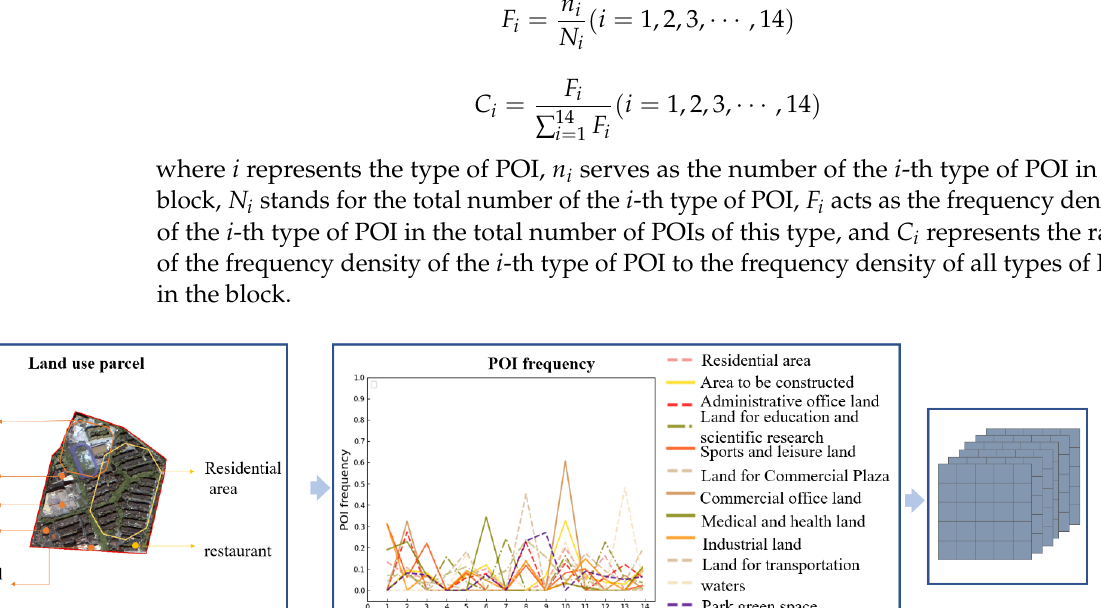
Figure 3. Building footprint of the study area. ( a ) building height distribution. ( b ) building length distribution. (c) building area distribution.